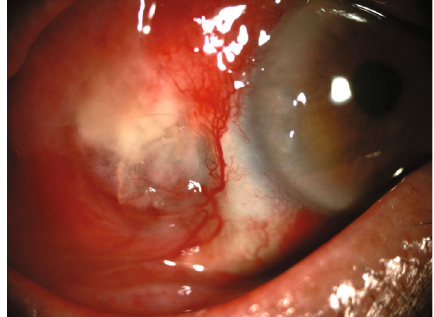
Figure 1: Slit-lamp photograph of the right eye of case 1, necrotic scleral thinning surrounded by edematous necrotic tissue was found at the temporal sclera near the